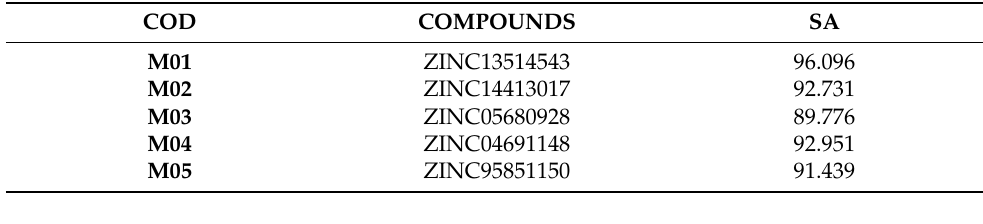
Table 5. Prediction of synthetic accessibility (SA) .